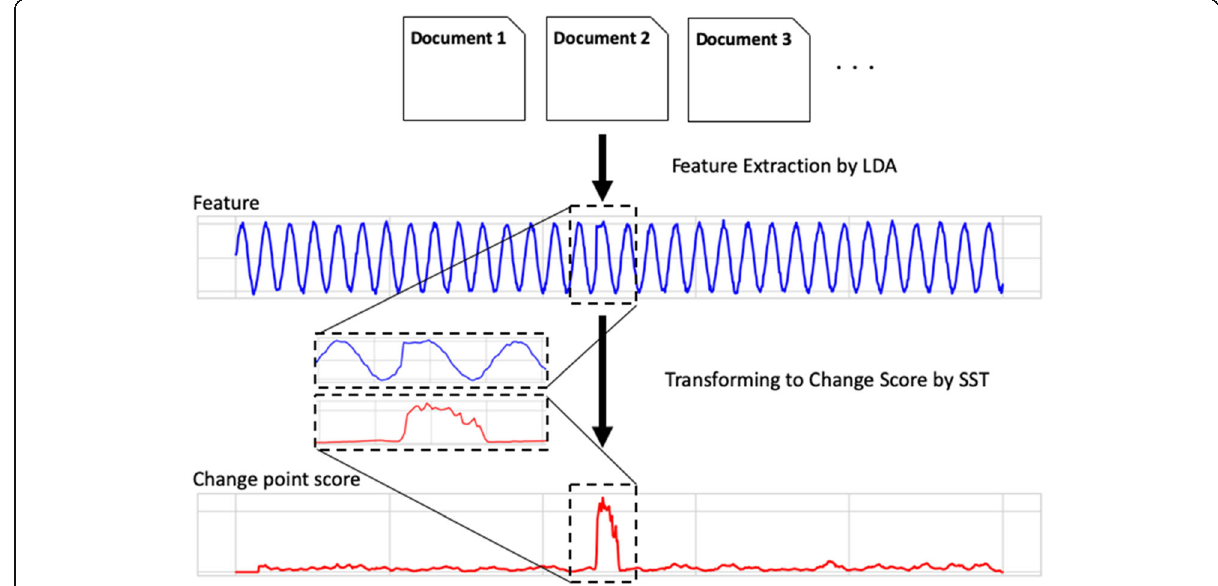
Fig. 3 Overview of topic variation detection (TVD) method for time-series text